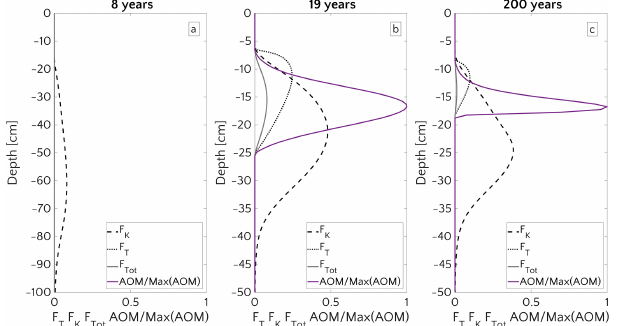
Figure 10. Vertical profile of F T , F K , F Tot = F K · F T and the AOM (scaled to the maximum) for three instants in time: 8 years (a) , 19 years (b) and 200 years (c) of simulation, for the case [ CH 4 ] − = 1 . 169mM and v up = 5cmyr − 1